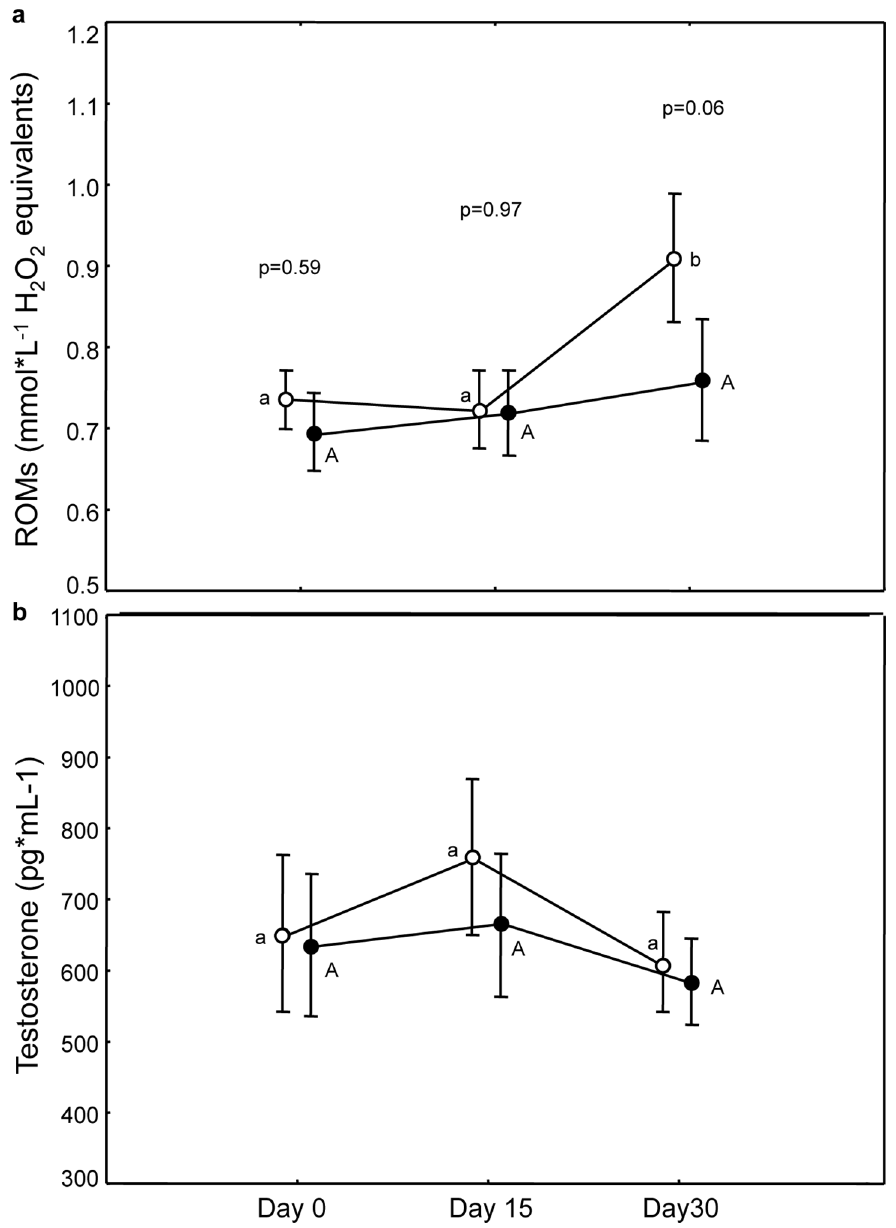
Fig. 4. Variation of oxidative damage (a) and testosterone (b) in the two treatments. P values refer to pairwise differences of least square means between groups within the same day. Post-hoc results within each group and between different days results are represented by letters (different letters indicate significant difference with what observed on day 0; capital for Caro-group and small letters for